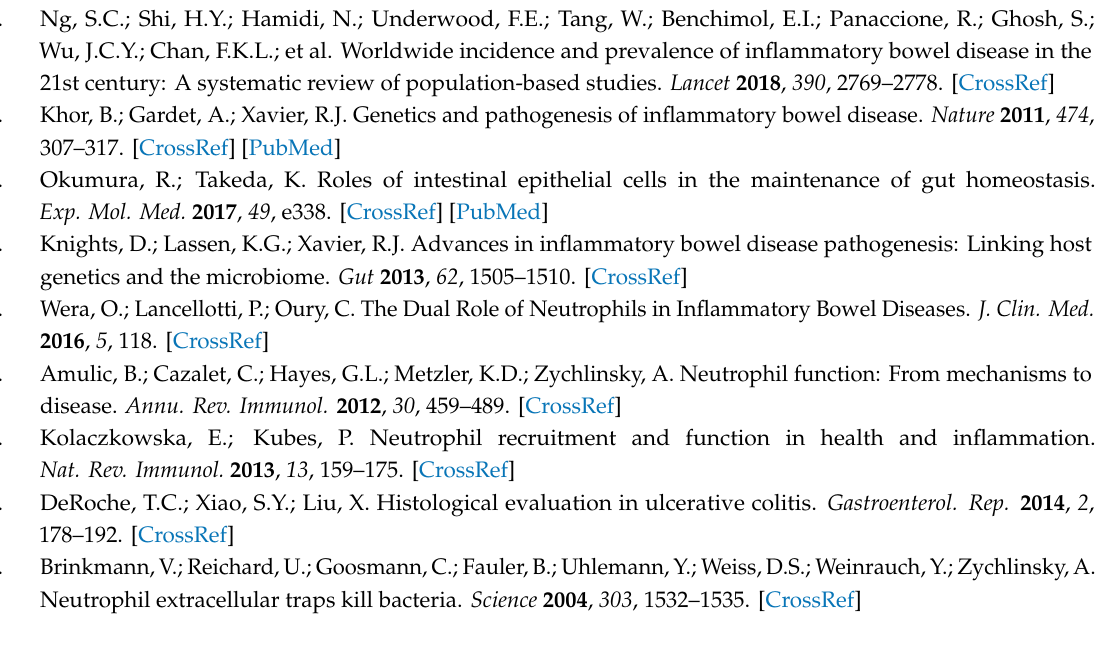
Figure S1: NET release was not detected in the plasma of DSS-induced colitis model in C57BL / 6 mouse. Colitis was induced by supplying 2.5% DSS in drinking water for 8 d. Mice that received water without DSS served as the controls (n = 6 mice per group). NET release was measured by using MPO-DNA ELISA.; Figure S2: Flow cytometric analysis of intestinal epithelium cells (IE) or lamina propria cells (LP) isolated from the colon of DSS-induced colitis with PBS or DNase I treatment on day 8. Representative plots showing cells were initially gated on CD11b + cells followed by staining of antibodies against Ly6G and F4 / 80. CD11b + Ly6G + F4 / 80- cells were defined as neutrophils; Figure S3: NETs alter intestinal barrier function and gene expression in the colon of DSS-treated mouse. (A) Bacterial count in the cecum of control or DSS mice treated with PBS or DNase I were determined on day 8. Results are pooled data from three separate experiments. n = 12 mice per control groups and n = 12 mice per DSS groups. (B) Quantitative RT-PCR analysis of occluding (Ocln) and ZO-1 (Tjp1) mRNA levels in the colon of control and DSS mice treated with PBS or DNase I. Values are normalized to the expression of Tbp. Results are pooled data from two separate experiments. n = 9 mice per control groups and n = 12 mice per DSS groups; Table S1: qPCR primers used in this